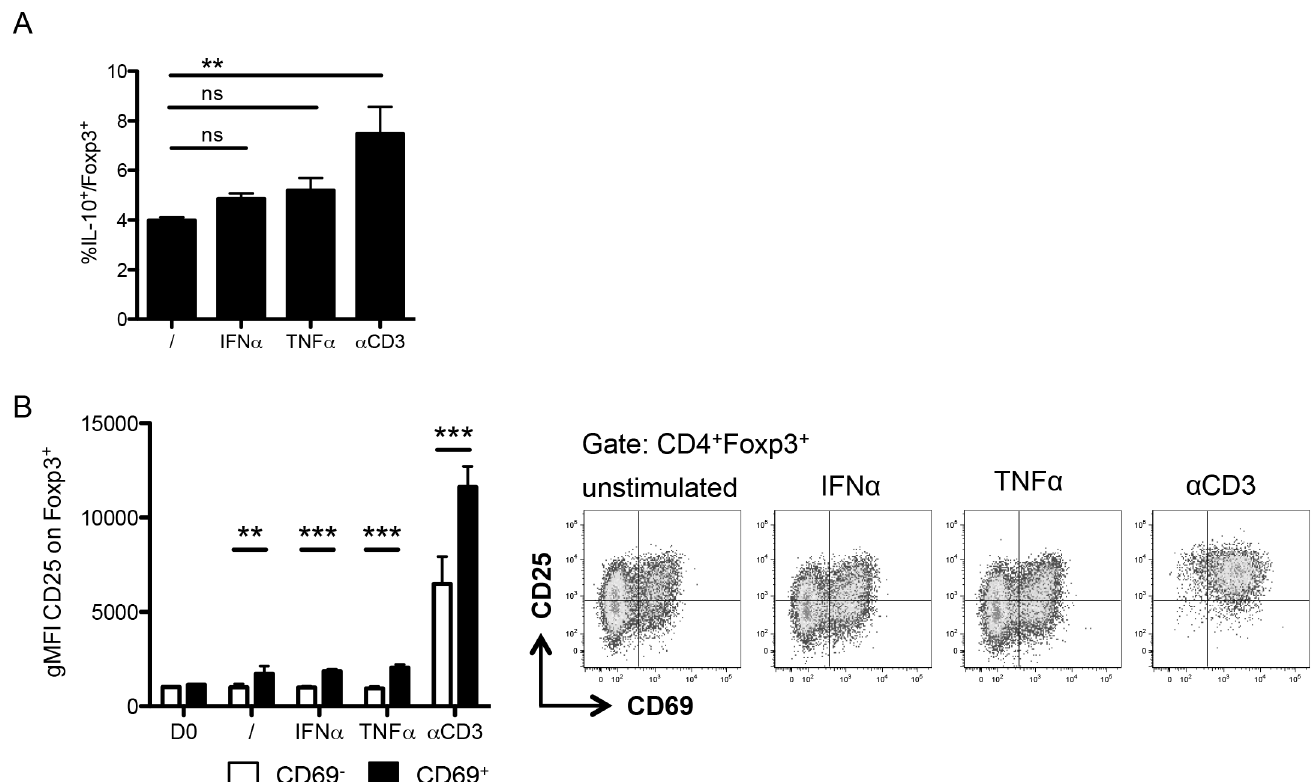
Fig 5. IL-10 and CD25 expression by cytokine-activated CD69 + Treg. (A) Frequency of IL-10 + cells by IL-10 intracellular staining on Foxp3 + among enriched CD4 + T cells stimulated overnight without additional cytokines (/), with IFN- α , TNF- α , or plate-bound α CD3. (B) Expression of CD25 by geometric mean fluorescence on CD69 + (black bars) and CD69 - (white bars) (left) and representative plots (right) of Foxp3 + among enriched CD4 + T cells stimulated as in (A). Data show mean + SD, ** p (cid:1) 0.01, *** p (cid:1) 0.001; ns, non significant. Data are representative of two independent experiments.